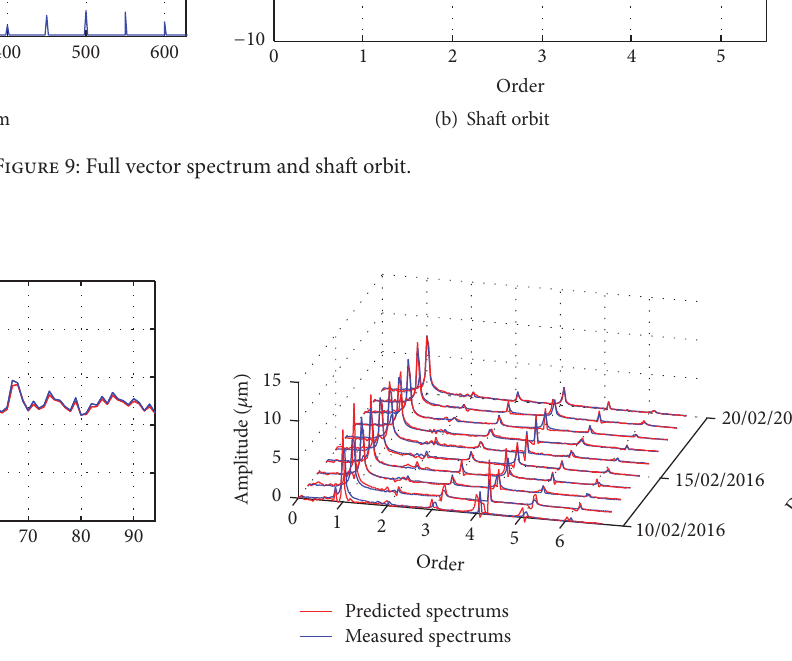
Figure 10: Comparison between predicted and measured values. Figure 11: Full vector spectrum prediction with AR( 13